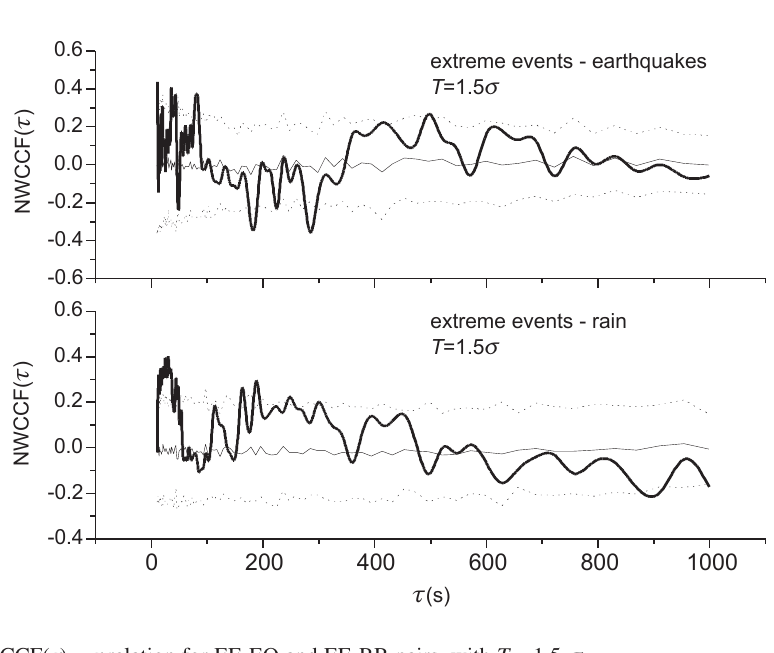
Fig. 3. NWCCF( τ ) ∼ τ relation for EE-EQ and EE-RR pairs, with T = 1.5 σ